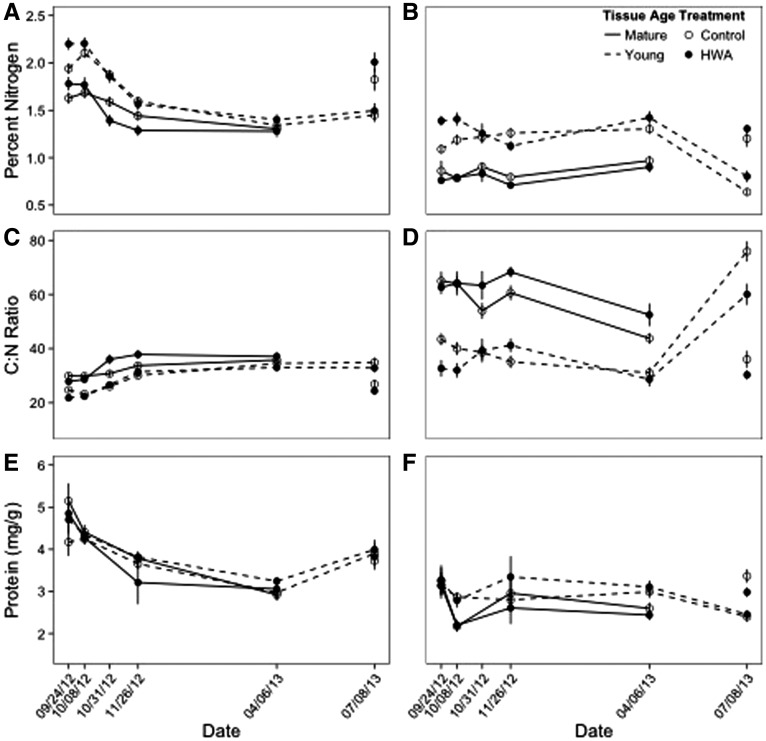
Percent nitrogen (A,B), carbon:nitrogen ratio (C,D), and protein (mg/g) concentration (E,F) of new, young, and mature needles (left-hand panels) and twigs (right-hand panels) from uninfested (open dots) or Adelges tsugae (HWA: hemlock woolly adelgid) – infested (closed black dots) Tsuga canadensis seedlings. Samples are coded by age as year of growth initiation (Mature: 2011 = solid lines; Young: 2012 = dashed lines). Unconnected dots represent New (2013) growth. Aestivation occurs from July to October.